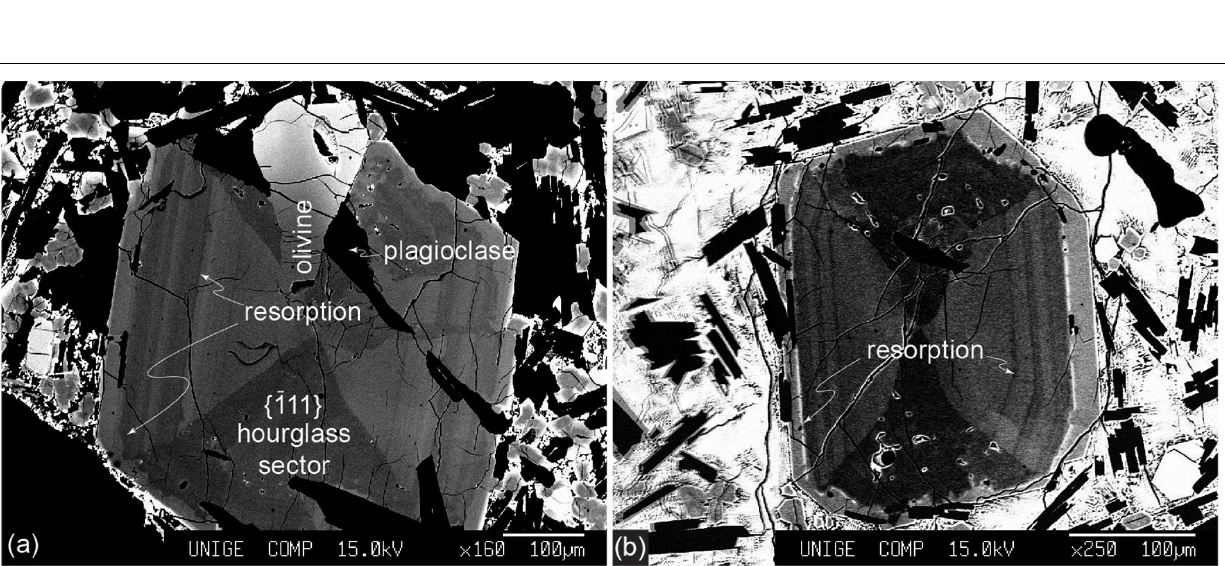
Frontiers in Earth Science | www.frontiersin.org